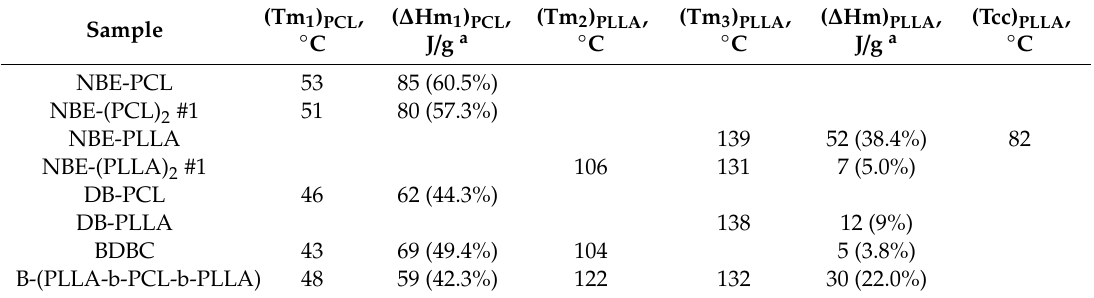
Table 5. Di ff erential scanning calorimetry results of the macromonomers and the polymer brushes.